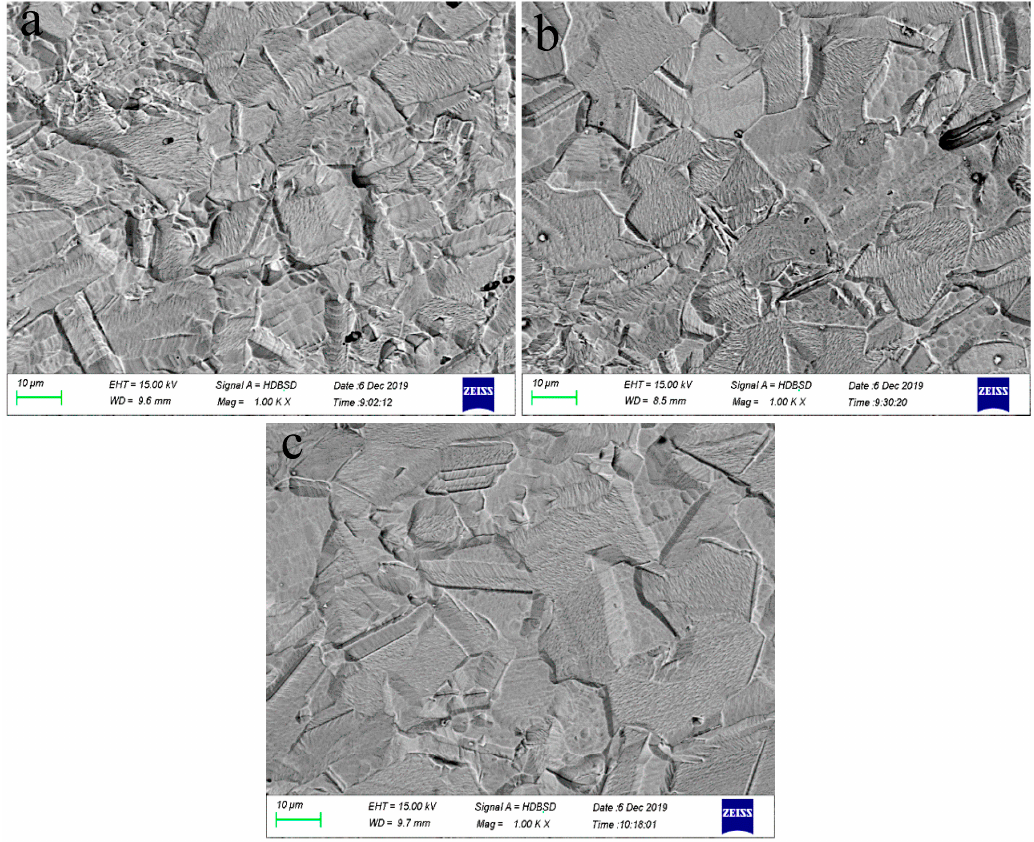
Figure 6. SEM pictures of recrystallisation areas of stainless steel samples with different Cu con- tent (( a ): 301ASS, ( b ): 301ASS-0.4Cu, ( c ): 301ASS-1.1Cu). (( a ): 301ASS, ( b ): 301ASS-0.4Cu, ( c ):